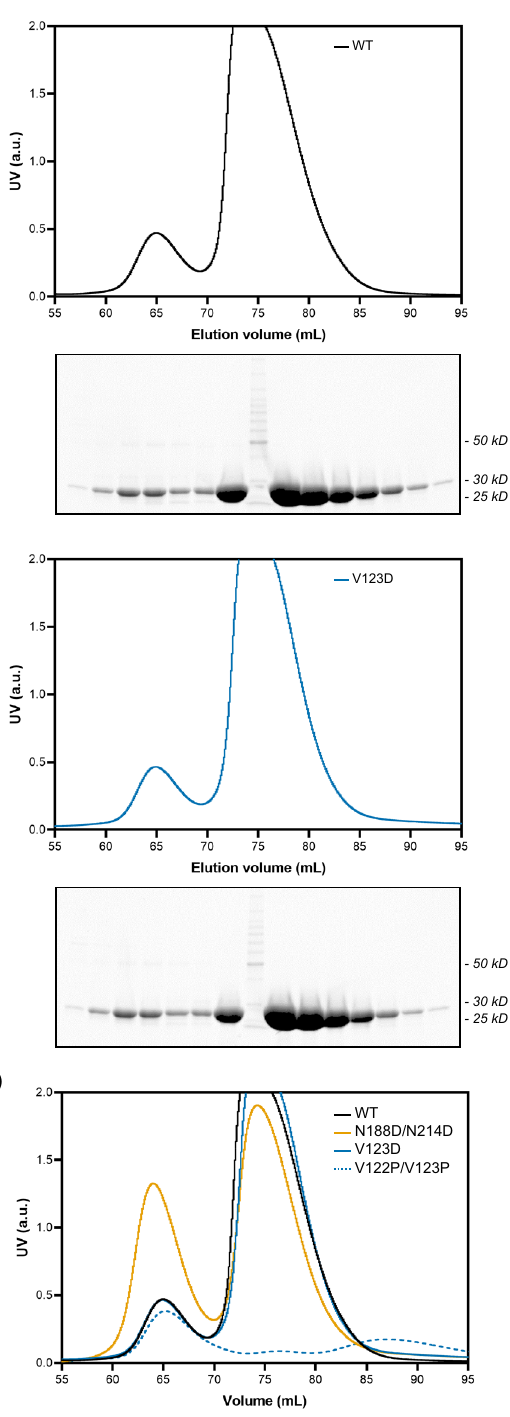
Figure 2. SEC and SDS-PAGE analysis of GRB2 WT and mutants. The SEC profile and SDS PAGE analysis of fractions spanning chromatographic peaks are shown for ( A ) GRB2 WT, ( B ) N188D/N214D, ( C ) V123D putative monomer, and ( D ) V122P/V123P putative dimer. For V122P/V123P, scale is adjusted to enhance peak prominence. ( E ) An overlay of all construct SEC profiles is